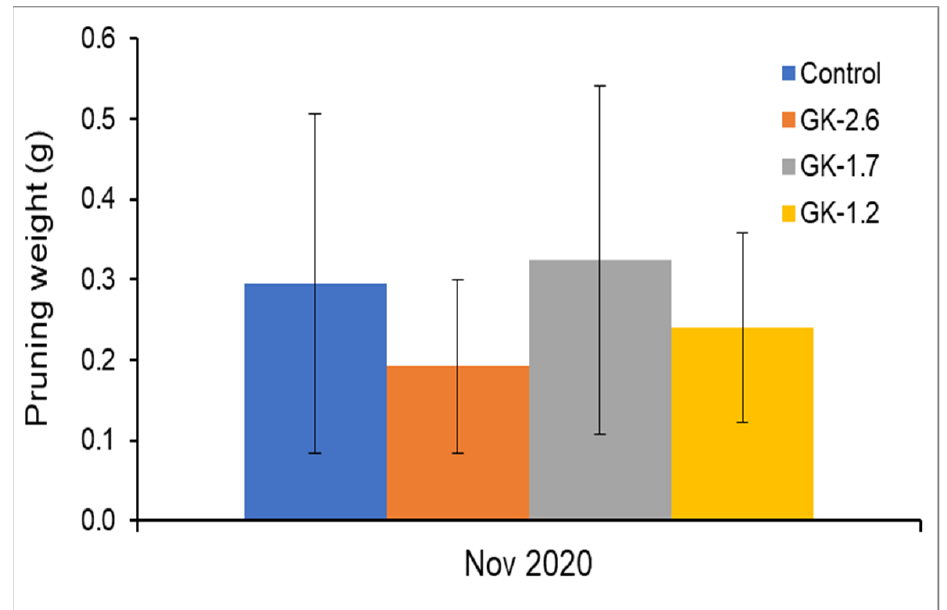
Figure 7. Pruning weight measured at the end of the growing season 2020. GK-1.2, GK-1.7 and GK-2.6 indicate the Grass Killer treatments at 1.2, 1.7 and 2.6 km per hour working speeds, respectively. Control = hoeing machine. No significant differences were recorded between treatments according to Tukey–Kramer HSD test ( p < 0.05). Data are means ± standard deviation of 30 replicates for Control and 10 for each forward speed of Grass Killer (GK) treatment. Table 4. Plant water status and diurnal leaf gas exchange registered at the beginning of August 2020 (48 days after the weed control treatment in the June